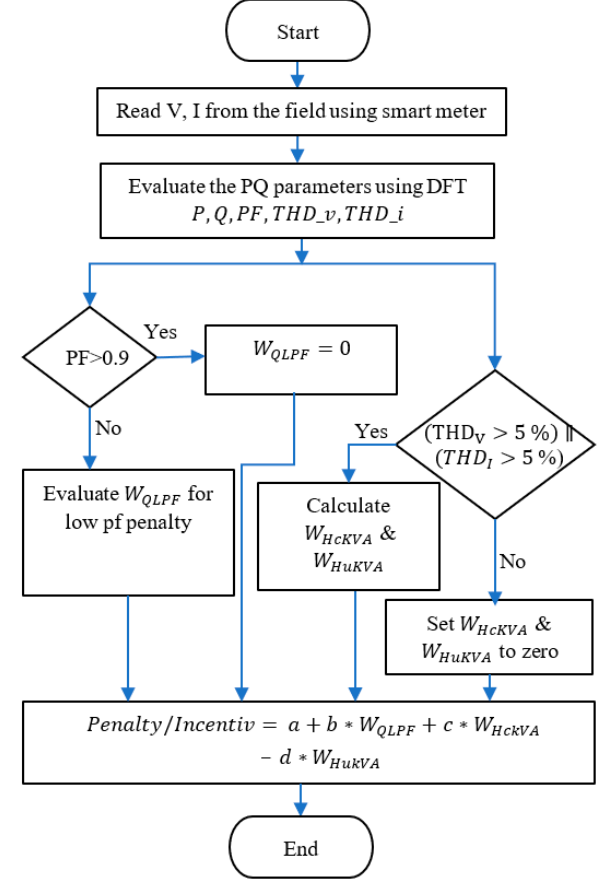
Figure 1. Flowchart of the proposed incentive/penalty scheme.